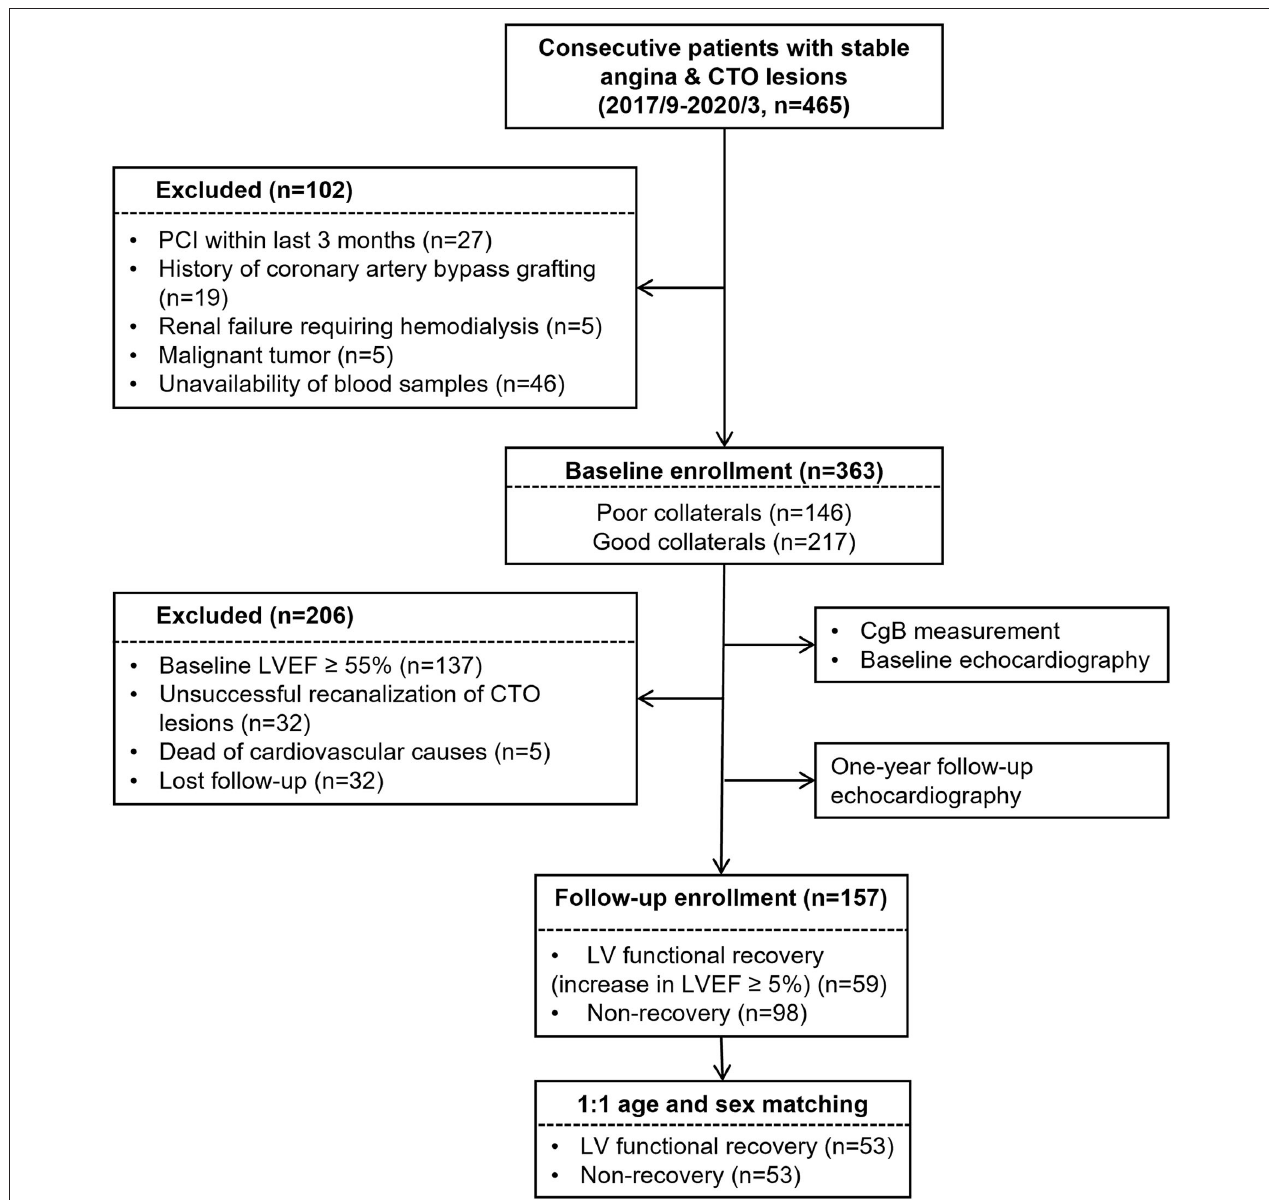
FIGURE 1 | Flowchart of patient